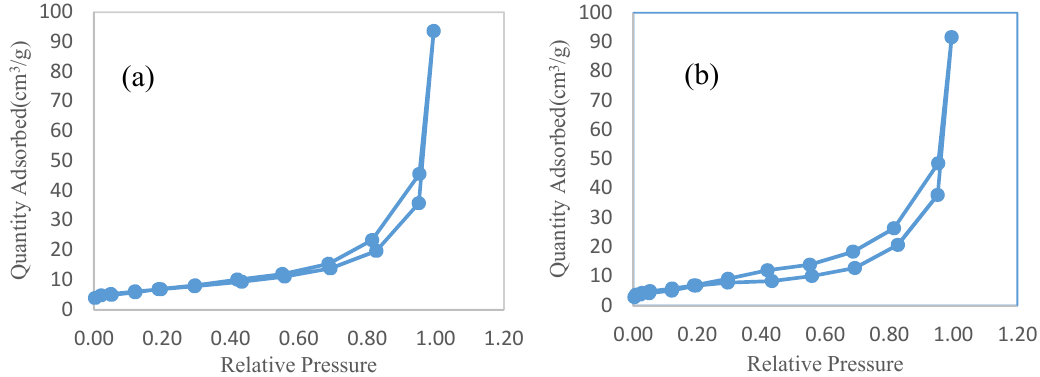
Figure 5. Nitrogen adsorption ‐ desorption isotherm of ( a ) Co 3 O 4 /TiO 2 catalyst ( b ) 8 wt.% ZrO 2 ‐ Figure5. Nitrogenadsorption-desorptionisothermof( a )Co 3 O 4 / TiO 2 catalyst( b )8wt.%ZrO 2 -Co 3 O 4 / TiO 2 Co 3 O 4 /TiO 2 catalyst .